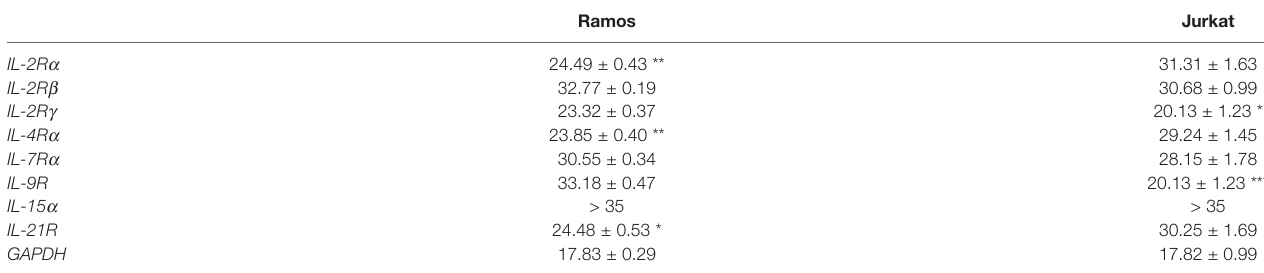
TABLE 2 | CT values for gene expressions of cytokine receptors in Ramos and